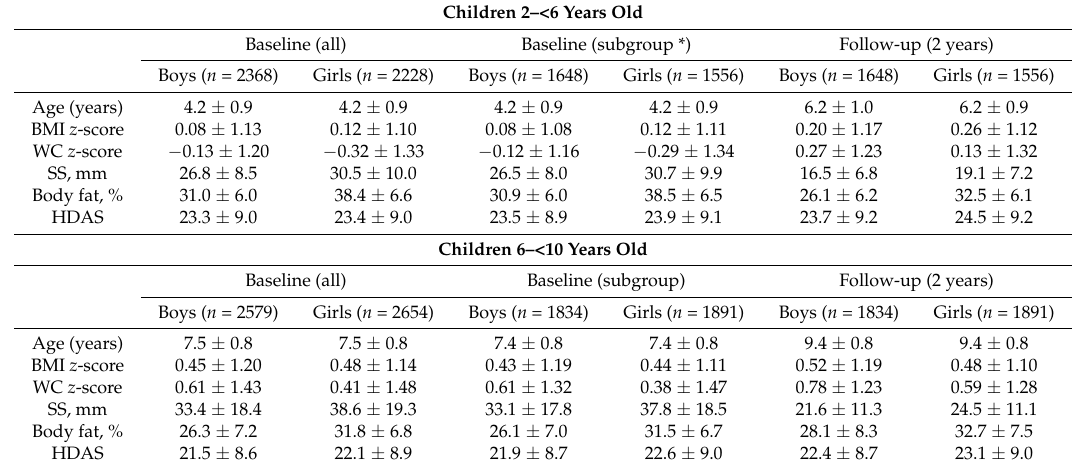
Table 1. Characteristics of the population at baseline and at the two-years